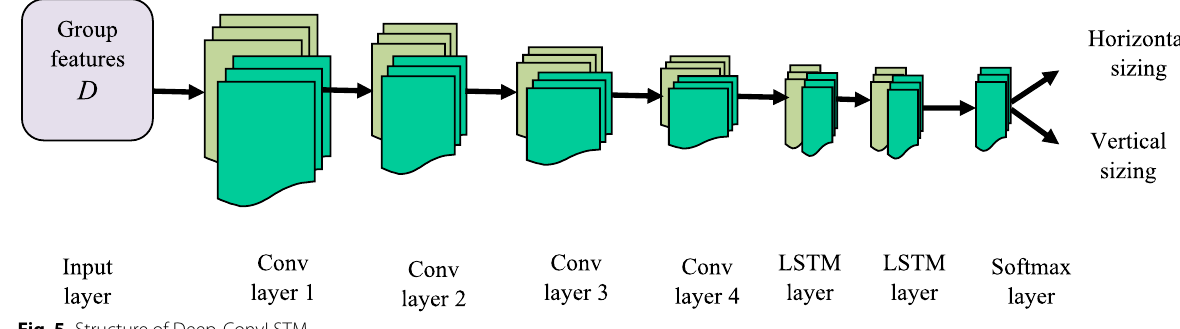
Fig. 5 Structure of